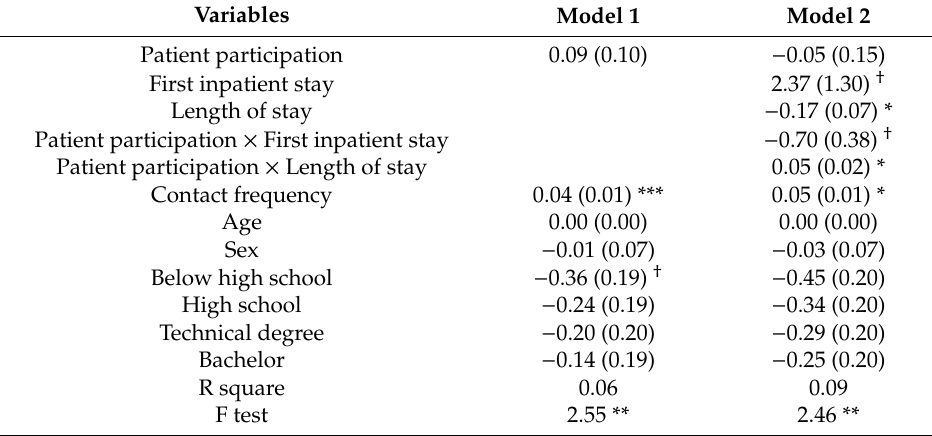
Table 4. Effect and boundary conditions of patient participation on patient satisfaction.